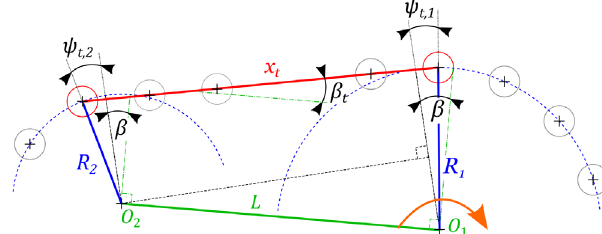
Fig. 5. Four-bar modelling of the tight strand.